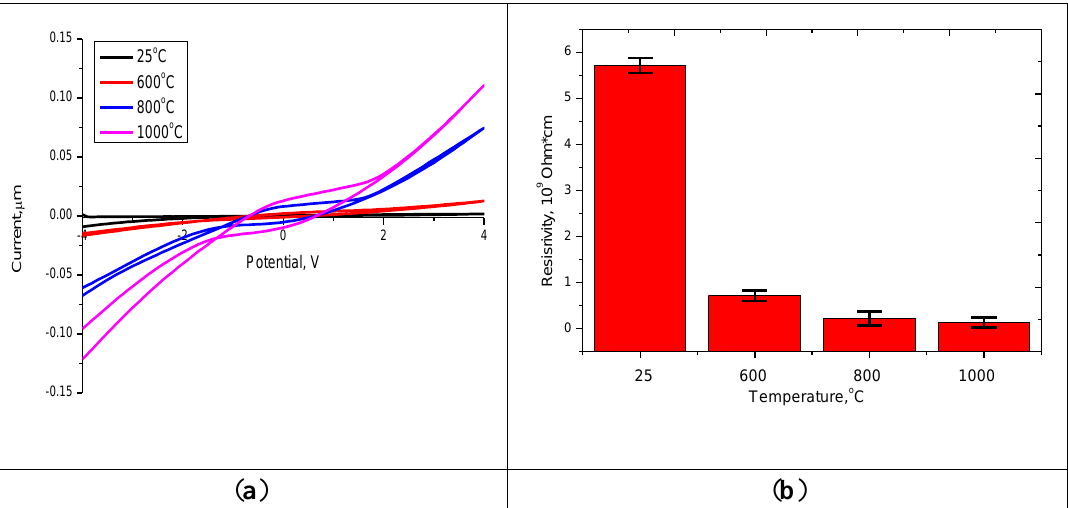
Figure 5. ( a ) I–V characteristics of the studied nanostructured ceramics Y 2 O 3 /TiO 2 -Y 2 TiO 5 doped CNTs. ( b ) The dynamics of changes in the resistance of the studied nanostructured ceramics.